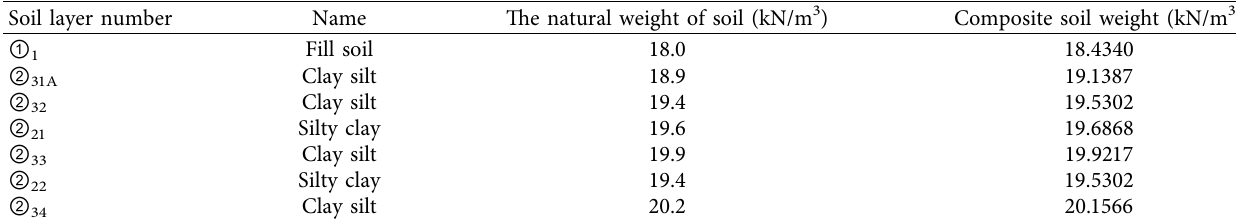
Table 2: Heaviness of the composite